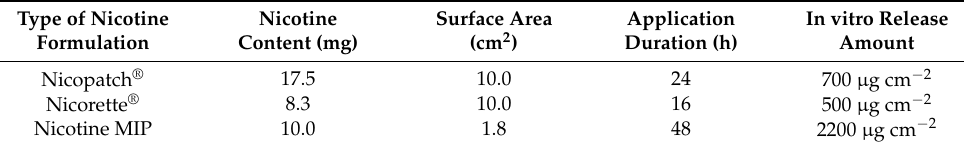
Table 1. Specifications of nicotine patch formulations